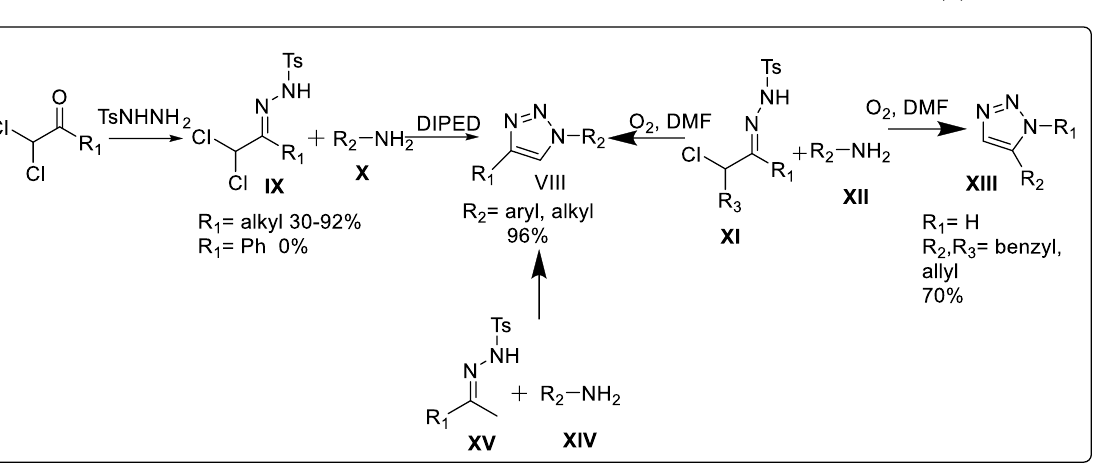
Figure 6. Metal-free methods of synthesizing 1,2,3-triazole. Synthesis of 1,2,3- triazole through α -chlorotosylhydrazones